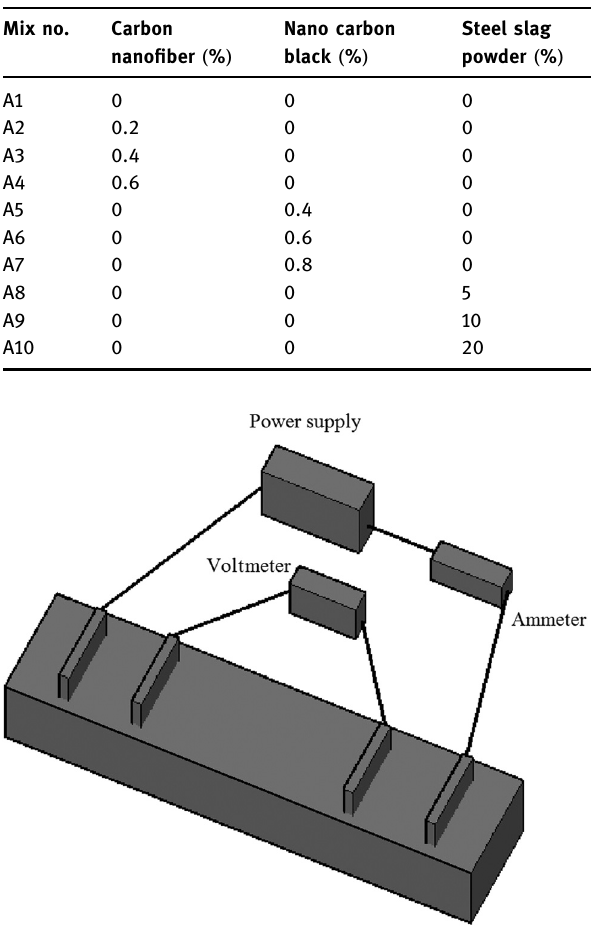
Figure 1: Measuring device of resistivity.